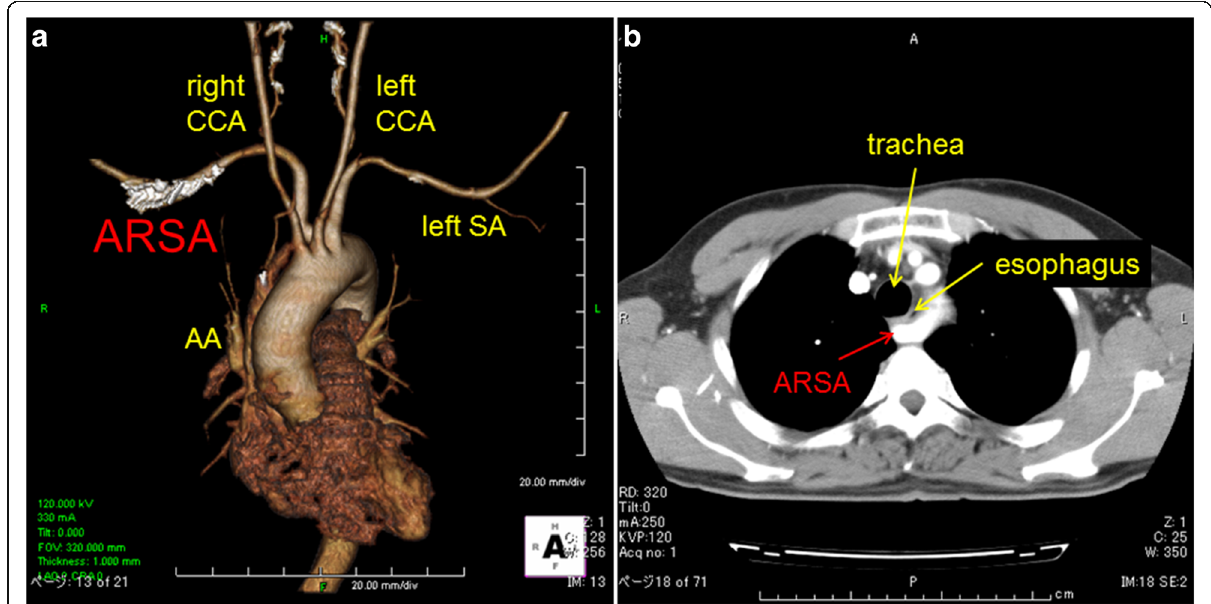
Fig. 1 Case 1. a Three-dimensional and b enhanced computed tomography scan showed an aberrant right subclavian artery arising from the dorsal side of the distal descending aorta and passing through the retroesophageal space. AA aortic arch, SA subclavian artery, CCA common carotid